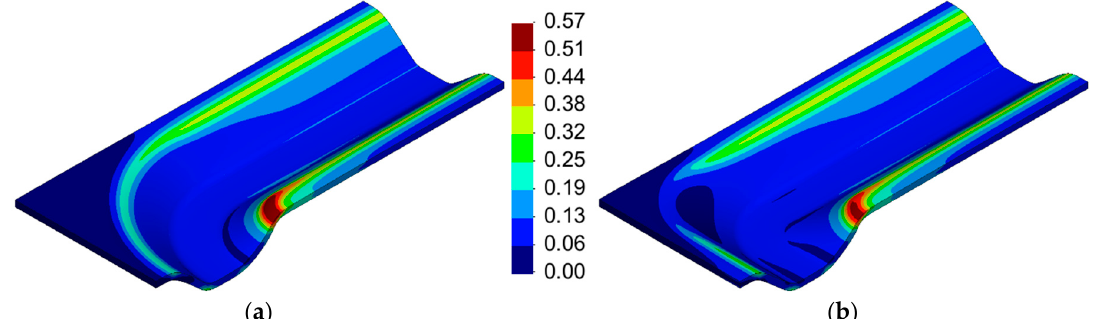
Figure 19. Equivalent plastic strain distribution plotted on the deformed configuration of the channel: ( a ) revolved tool geometry in the U-bend channel section; ( b ) rounded bend in the U-bend channel section.